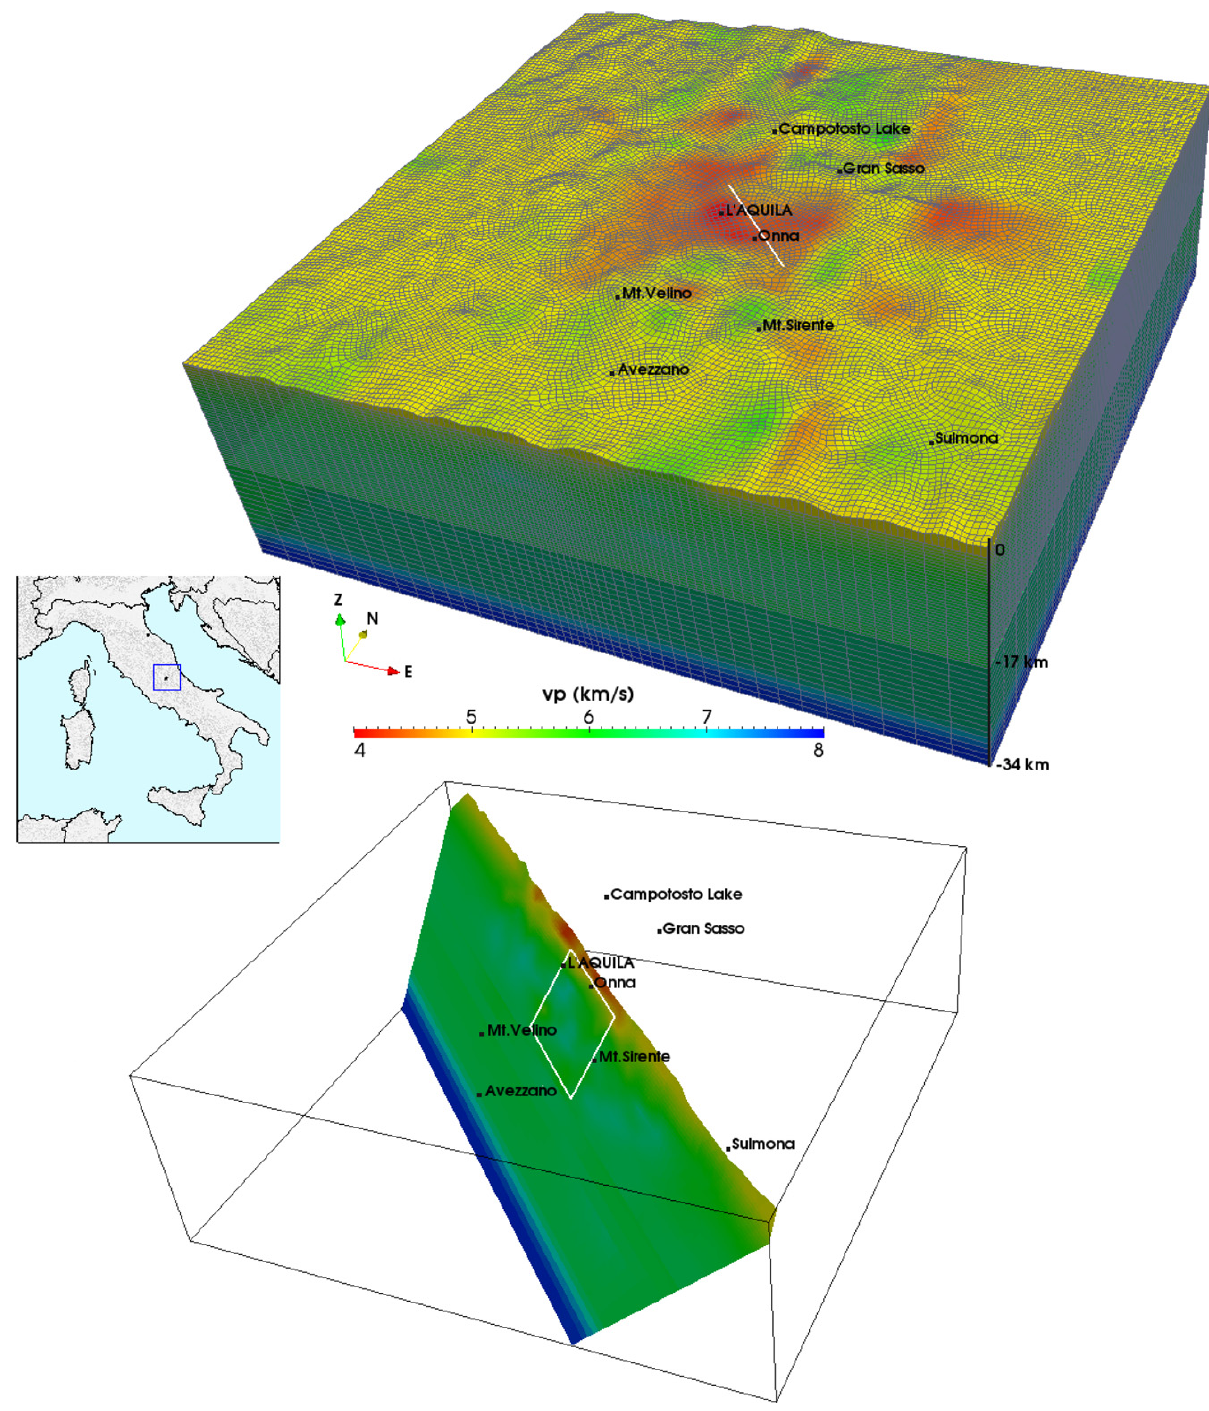
Figure 2. Image of the 3D simulation meshed volume with tomographic model included, viewed from SW. Topographic reliefs have been enhanced for a better visualization.The compressional wave velocity is shown in the whole domain (top figure) and on a section along the fault plane (bottom